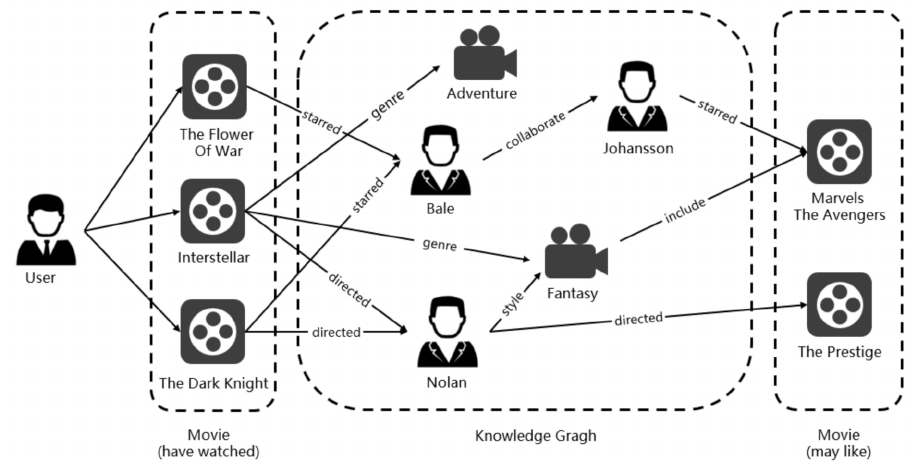
Figure 1. Knowledge graph-based recommendation